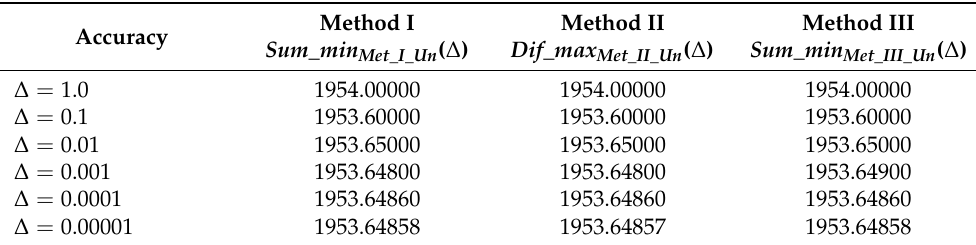
Table 10. Estimated lines lengths d ∆ of the reconstructed image for a given accuracy ∆ using the methods proposed by the authors.